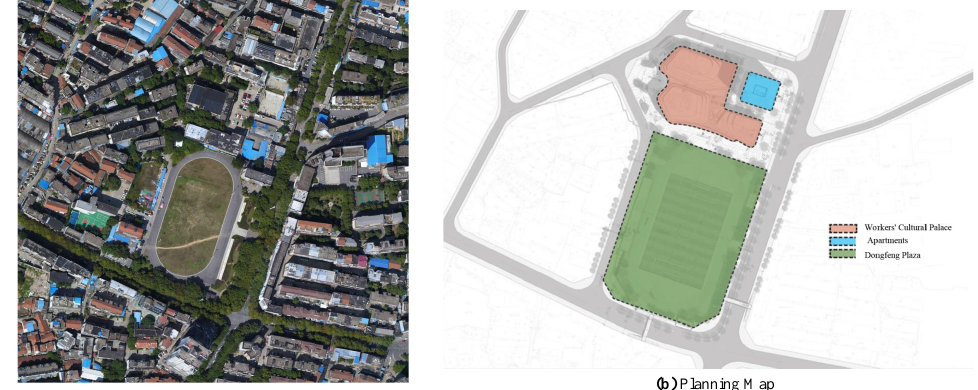
Figure 4. Relevant real-world view of the project.